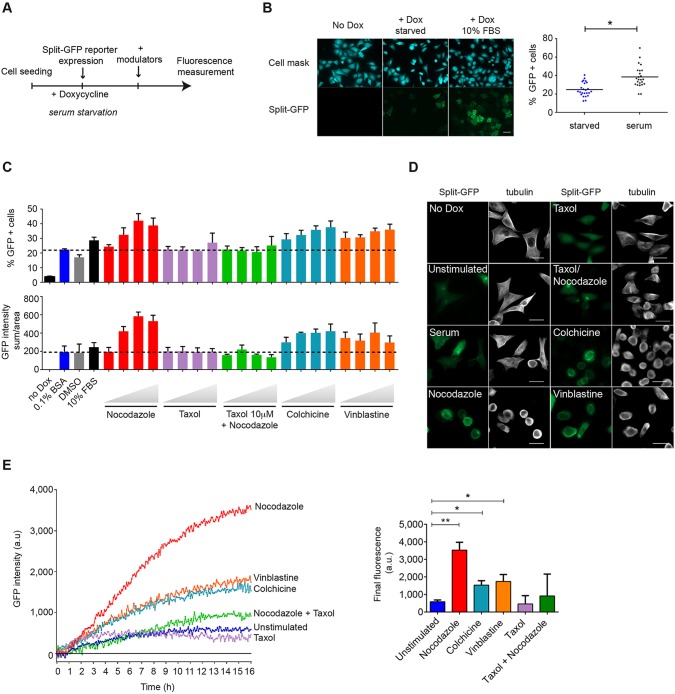
High-content analysis of RhoB activation. (A) Protocol used to evaluate RhoB modulators; the split-GFP reporter was expressed in serum-starved conditions prior to stimulation. (B) RhoB activation reporter cells were stained with a blue cell mask for quantification of the percentage of GFP-positive cells on a high-content Operetta imaging® system. The threshold for quantifying GFP-positive cells is set relative to that in uninduced conditions (no Dox). The graph shows an analysis of eight single measurements in serum-starved (+Dox, starved) and serum-stimulated (+Dox, 10% FBS) conditions. Results are mean±s.e.m.; n=3 independent experiments. *P<0.05 (paired Student's t-test). (C) Quantification of RhoB activation after treatment with the indicated compounds. Experiments were performed to analyze the percentage of GFP-positive cells or the sum of GFP intensities on the cell surface area. Controls: uninduced (no Dox), induced starved-conditions (0.1% BSA) or 0.1% BSA with DMSO (DMSO) or serum (10% FBS). Compounds: nocodazole (0.2, 1, 5, 10 µM), Taxol (1, 2, 5, 10 µM), 10 µM Taxol with 30 min treatment prior to nocodazole stimulation (0.2, 1, 5, 10 µM), colchicine (0.1, 1, 10, 25 µM), vinblastine (50 and 100 nM, 1 and 5 µM). Results are mean±s.e.m. of three independent experiments. For each experiment, data are means of eight replicates for no Dox, serum and starved control conditions, and duplicates for the other conditions. (D) Representative microscopy images of the corresponding high-content plate analysis. Split-GFP fluorescence is shown by the FITC channel and α-tubulin staining is in gray. Scale bars: 40 µm. (E) Fluorescence kinetic curves of RhoB activation following stimulation with 5 µM nocodazole, 10 µM Taxol, 10 µM Taxol+5 µM nocodazole, 1 µM colchicine and 0.1 µM vinblastine. Final GFP fluorescence values for the indicated conditions are shown on the right. Results are mean±s.e.m.; n=3 independent experiments. *P<0.05; **P<0.01 (Student's t-test).